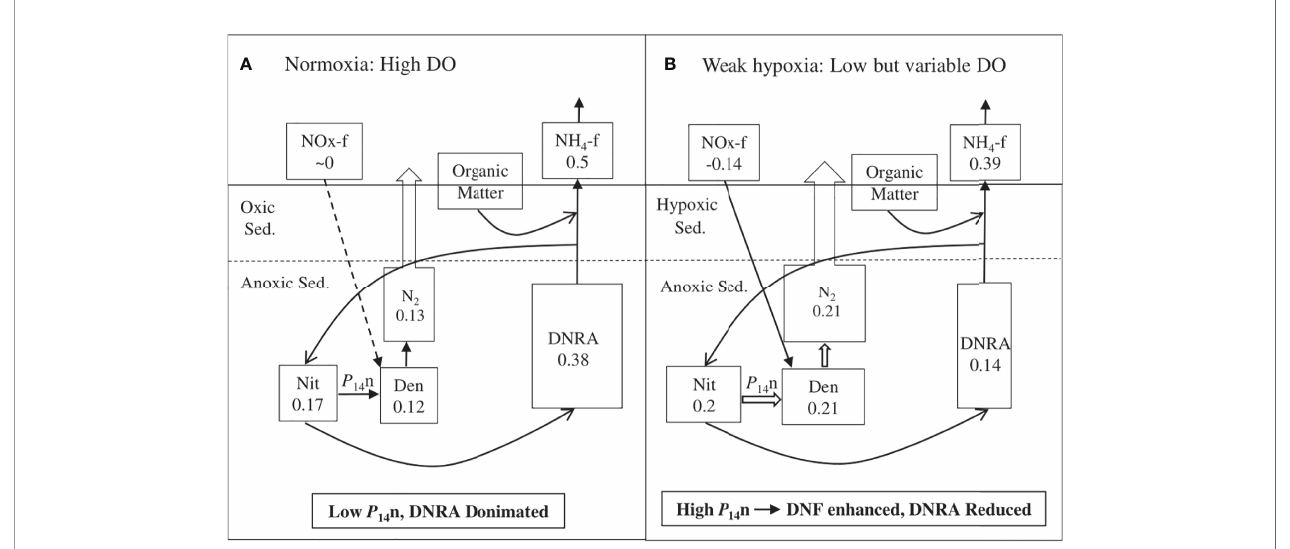
FIGURE 4 | Representation of principal annual nitrogen pathways and their rates investigated from 2015 to 2019 in Jinhae Bay during (A) normoxia and (B) weak hypoxia periods. Unit: mmol N m -2 d -1 for related benthic nitrogen transformations. DNF denotes denitri fi cation, DNRA denotes dissimilatory nitrate reduction to